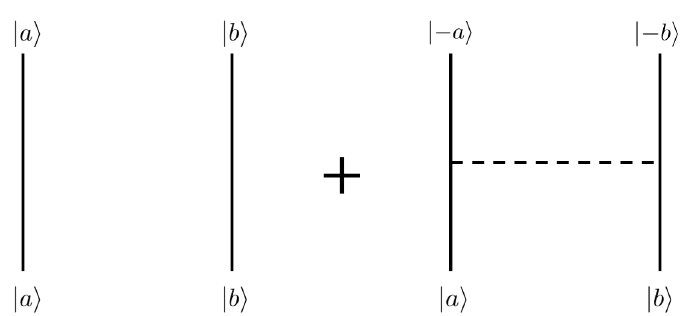
Figure 6. The diagrammatic picture of the coherence generation by the exchange of the scalar